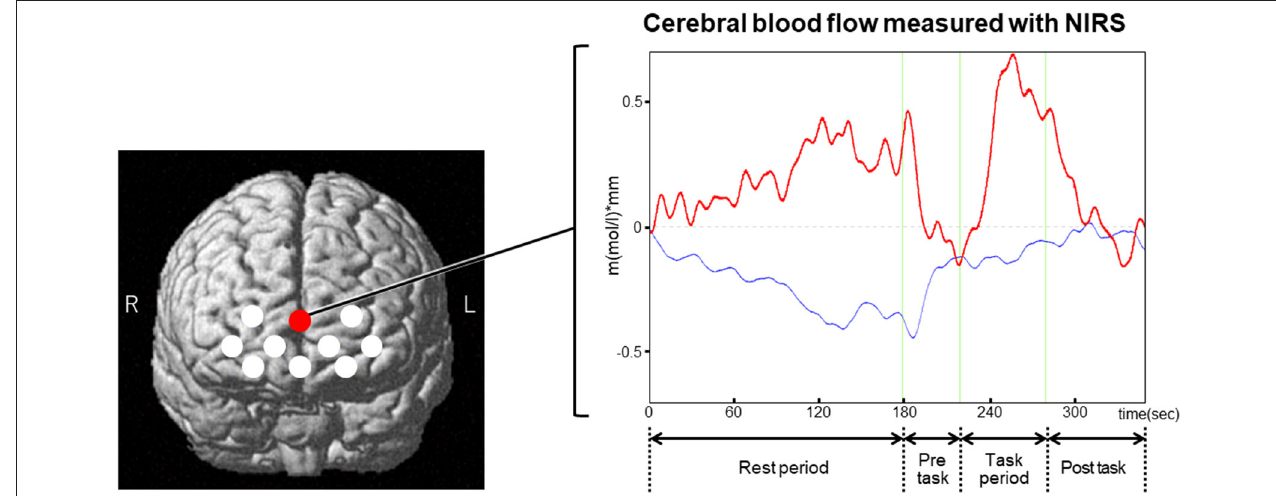
FIGURE 1 | An example of NIRS measurement using a resting paradigm that was followed by a verbal fluency task. The left figure displays NIRS channel locations that are indicated by the white and red circles. The red circle points to the channel that displays an example (right figure) for the time course of NIRS signals in a healthy subject. In this case, the NIRS signals were potently activated during the rest period. The activation of the signals was reversed during the subsequent pre-task, where the subject simply repeated a sequence of syllables (a, i, u, e, o). The NIRS signals were activated again during the task period for the verbal fluency task, which asks the subject to generate as many words as possible starting with presented syllables such as “a.” The activation of the signals induced by the verbal fluency task was reversed during the post-task, which consisted of the same task as the pre-task. The magnitudes of the activated signals during the rest period were nearly comparable with those induced by the verbal fluency task. This potent activation of the NIRS signals may indicate some spontaneous cognitive activity that occurred during the rest period. Red bold line, oxy-hemoglobin signal; blue line, deoxy-hemoglobin